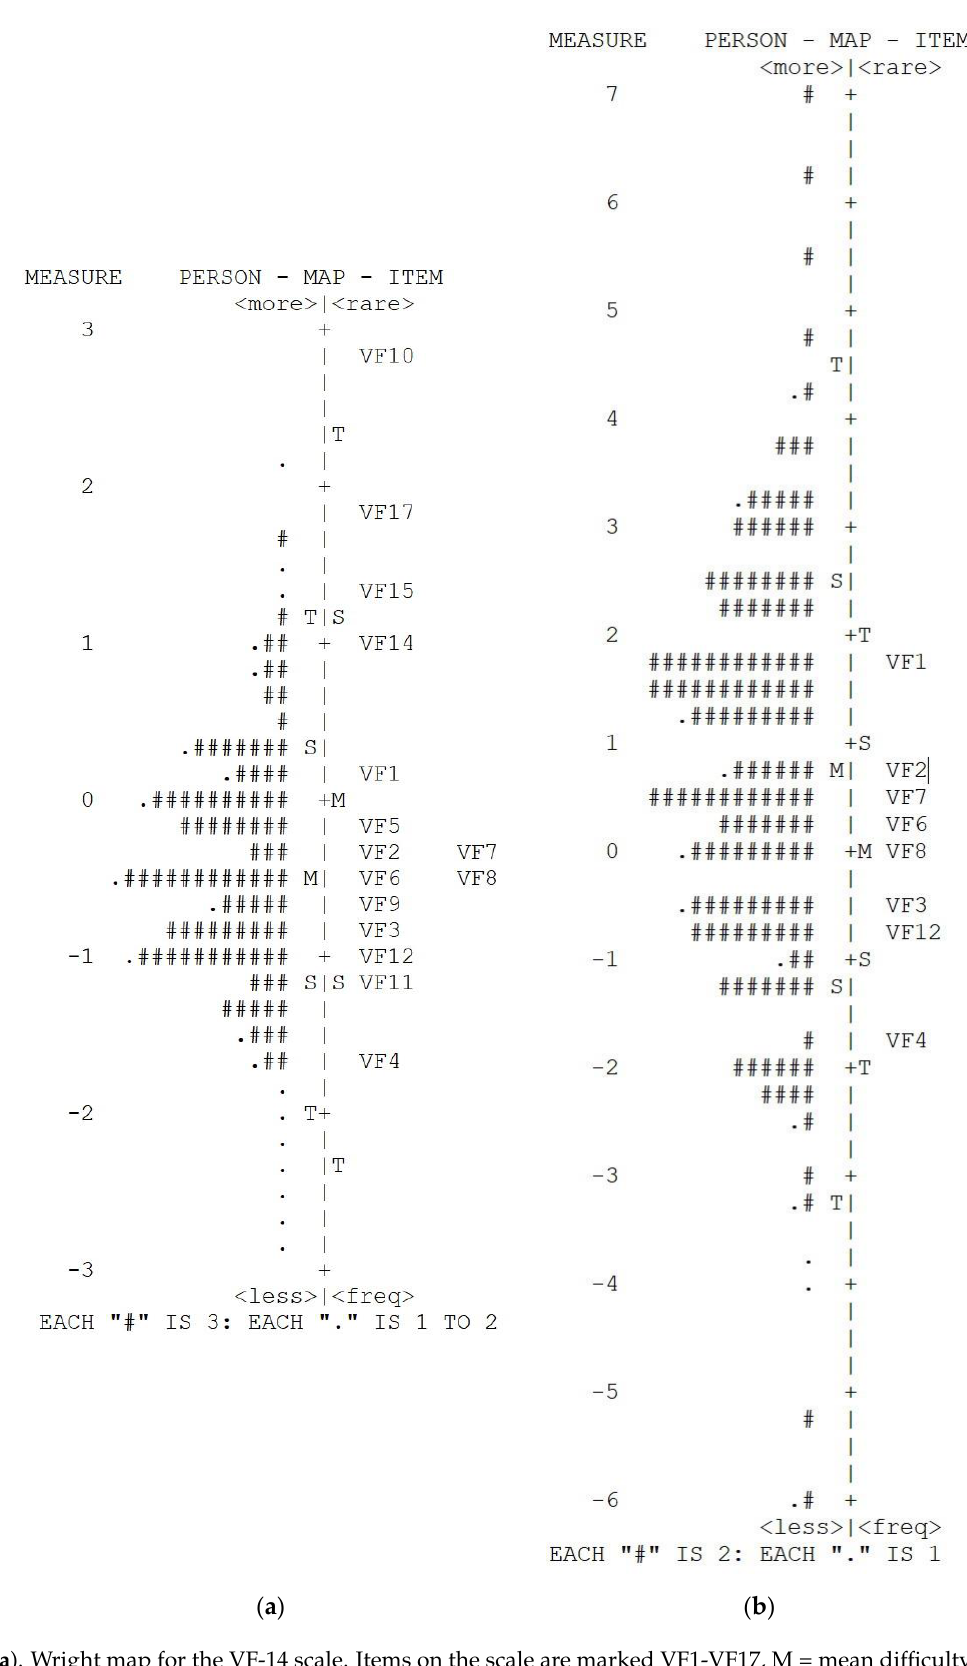
Figure 2. ( a ). Wright map for the VF-14 scale. Items on the scale are marked VF1-VF17, M = mean difficulty of the items, S = one standard deviation, T = two standard deviations; ( b ). Wright map for the VF-8G scale. Items on the scale are marked VF1-VF12, M = mean difficulty of the items, S = one standard deviation, T = two standard deviations.